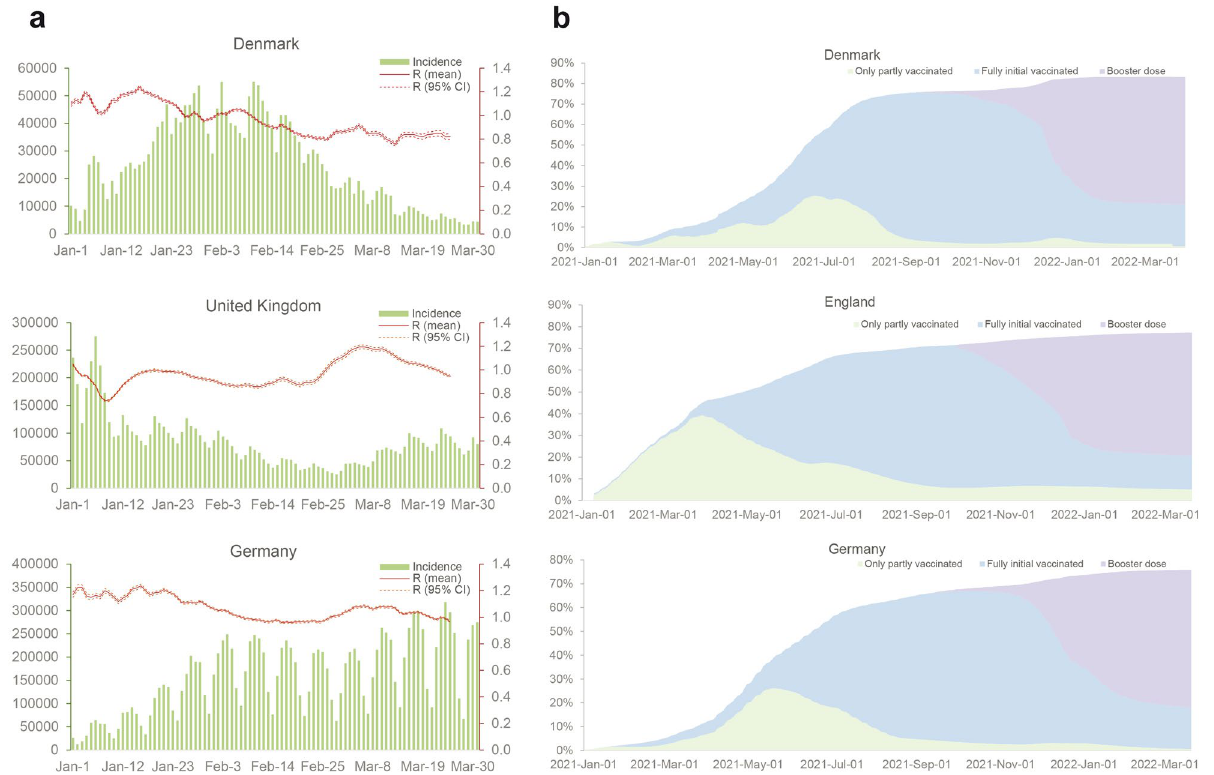
Figure 2. Simulating the transmission dynamics and pandemic burden of Omicron waves. ( a ) The time- varying reproduction number estimation and epidemiological dynamics. ( b ) The dynamics of vaccination coverage by types. Incidence curve represents the number of daily new confirmed cases reported by WHO. The time-varying reproduction number was computed from epidemic incidence curves recorded by the WHO, and the dotted lines parts represent the 95% confidence interval. The vaccination data is retrieved from Our World in